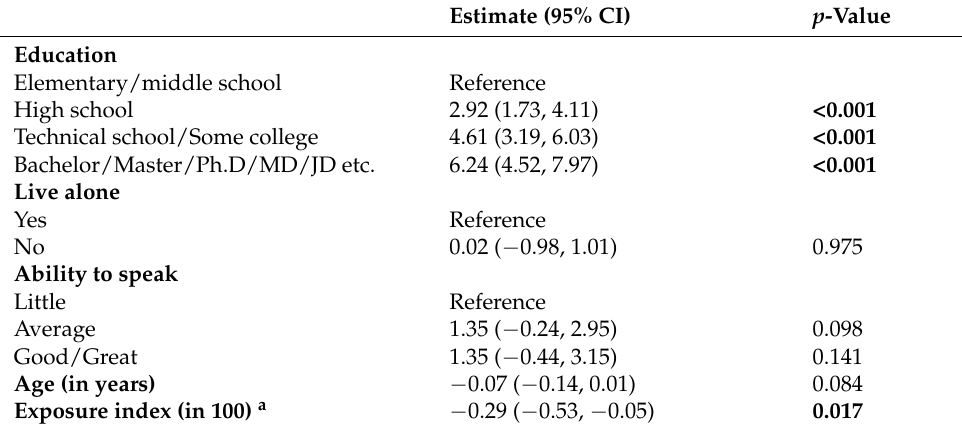
Table 3. Association between MoCA and factors using multiple linear regression in all participants without missing values in variables ( n = 269).